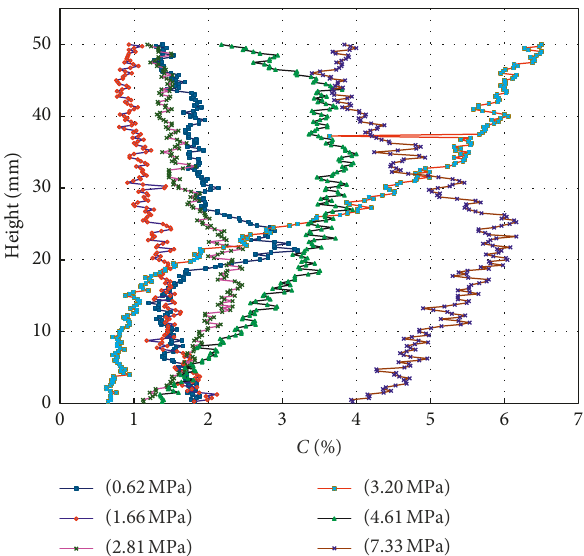
Figure 8: Distribution of single-layer crystal content along the height direction at different